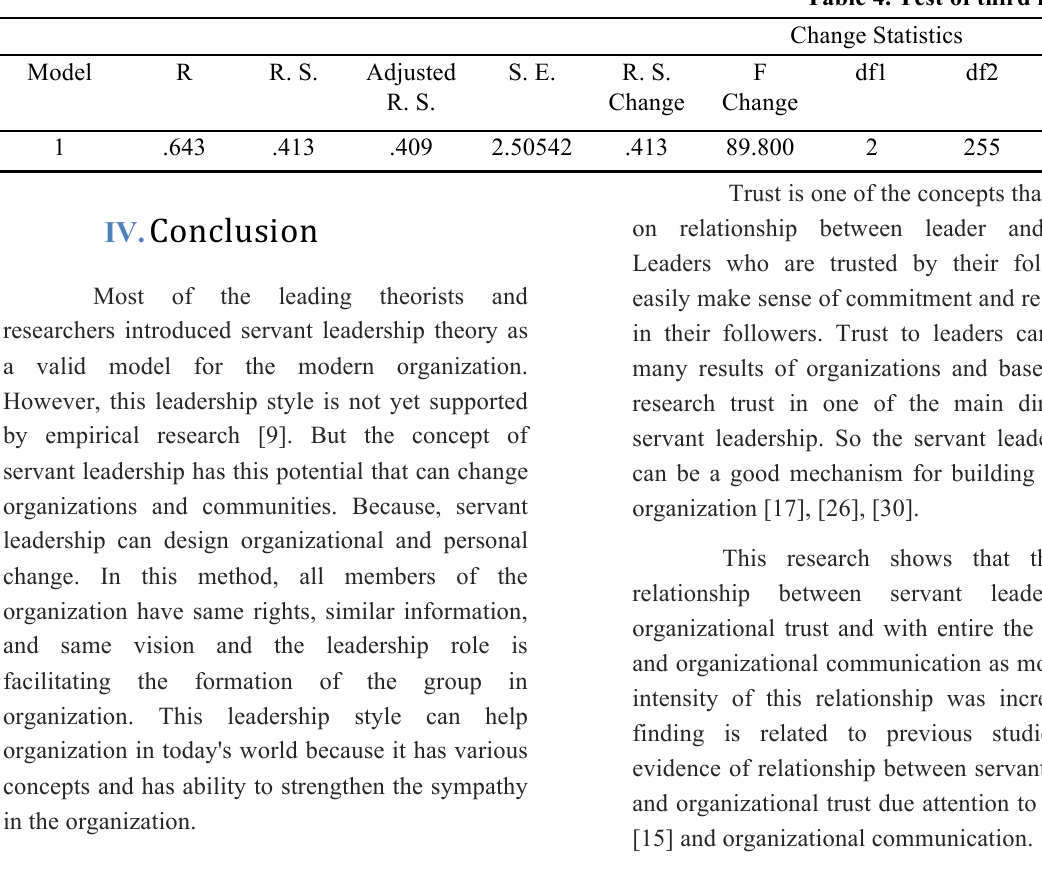
Table 4. Test of third